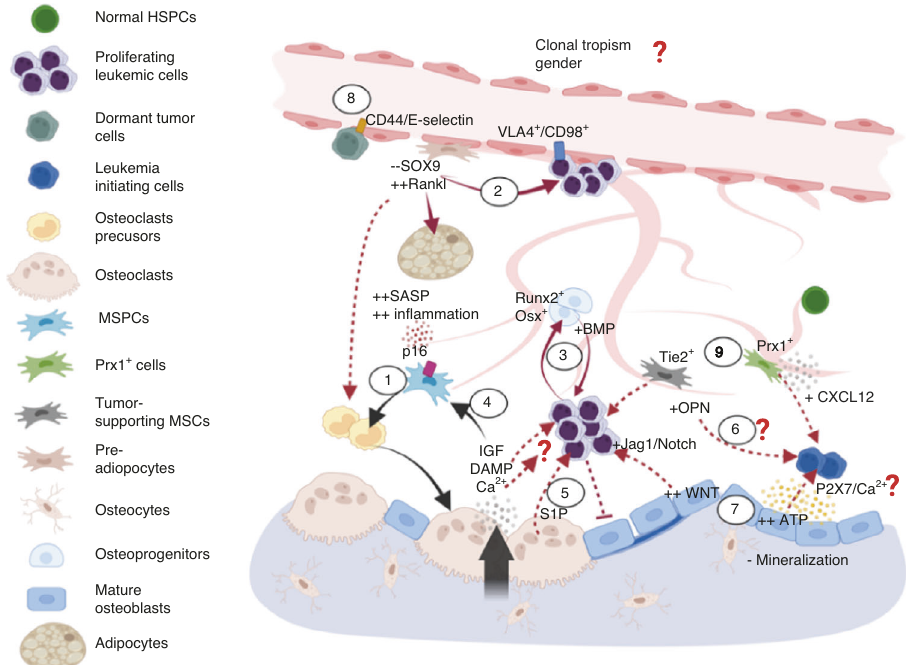
Fig. 5 Crosstalk between skeletal aging and age-associated myeloid diseases. (1) MSPC senescence augments the proin fl ammatory microenvironment (Fig. 4) in MDS/leukemia. (2) An adipogenic propensity promotes the survival of leukemia blasts, although it has been found that (3) in AML, Runx2 + and Osterix + osteoprogenitors are expanded via BMP signaling to enhance leukemia engraftment. (4) In addition, growth factors released during bone resorption have been shown to drive SASP acquisition (via IGF) and activate in fl ammasome NLRP3 (via DAMPs and calcium), which is overexpressed in MDS patients. (5) Coupling factors in the reversal stage may play roles in disease progression. S1P/S1PR 3 participates in leukemogenesis, myeloid bias and promotes LSC differentiation. In contrast, (6) OPN has been found to drive cell dormancy in B-cell acute lymphoblastic lymphoma; however, its role in MDS and AML still needs to be elucidated. (7) The